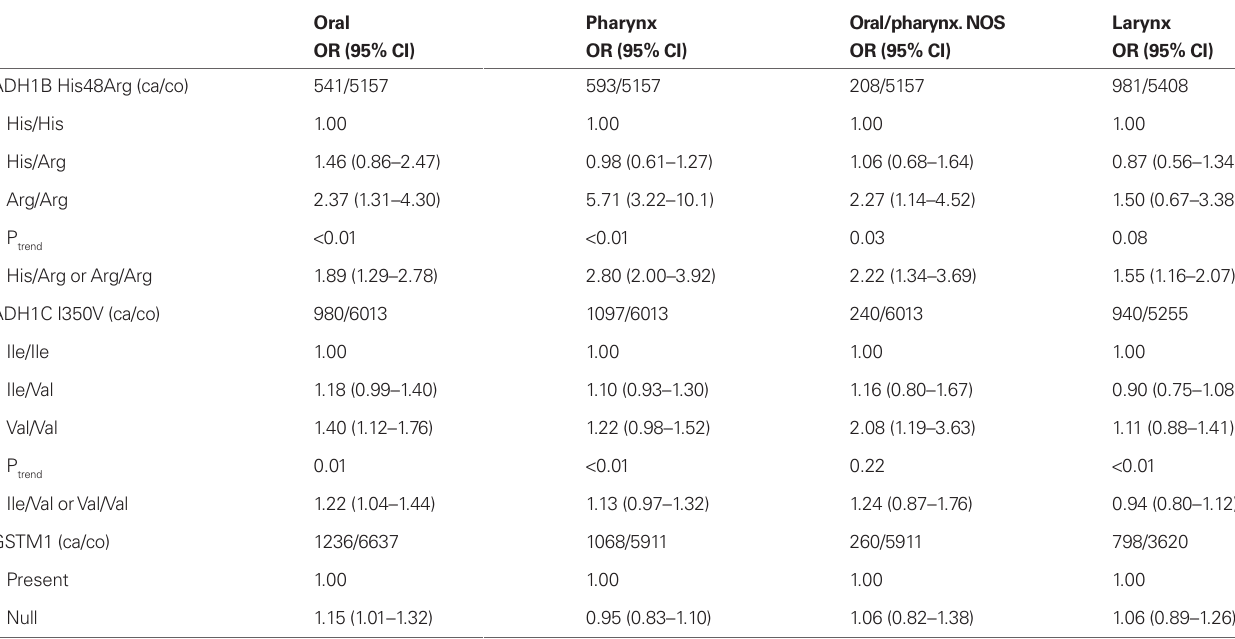
Table 5 | Selected SNPs and the risk of head and neck cancer by